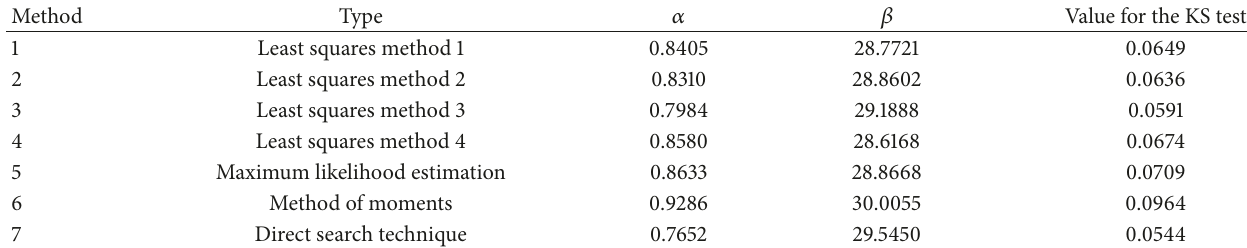
Table 4: The value for the KS test from a variety of estimation methods.